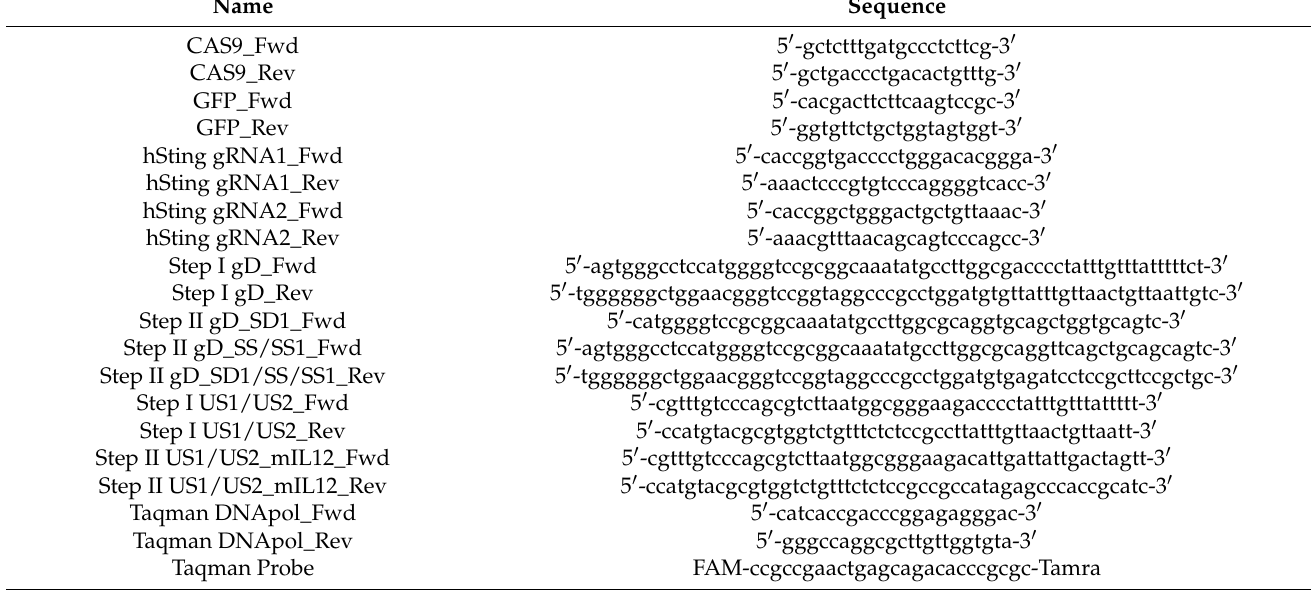
Table 1. Oligonucleotide